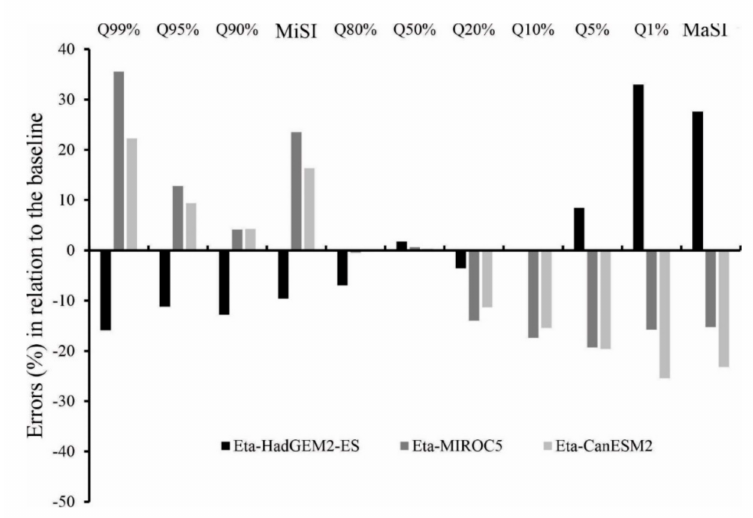
Figure 9. Performance of the LASH model along with the RCMs in simulating the flow duration curve (FDC) indicators for the baseline.